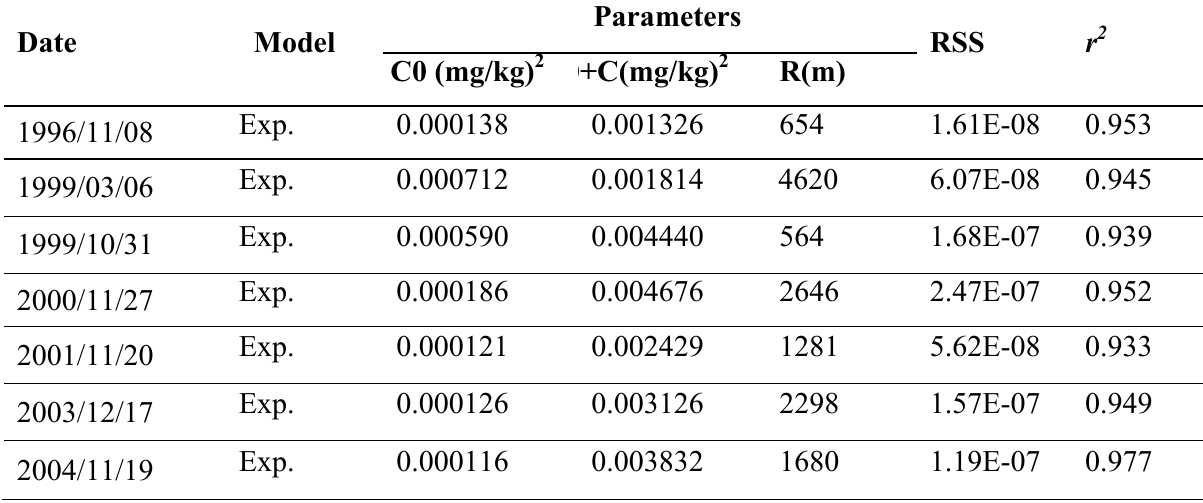
Table 3. Variogram models of NDVI